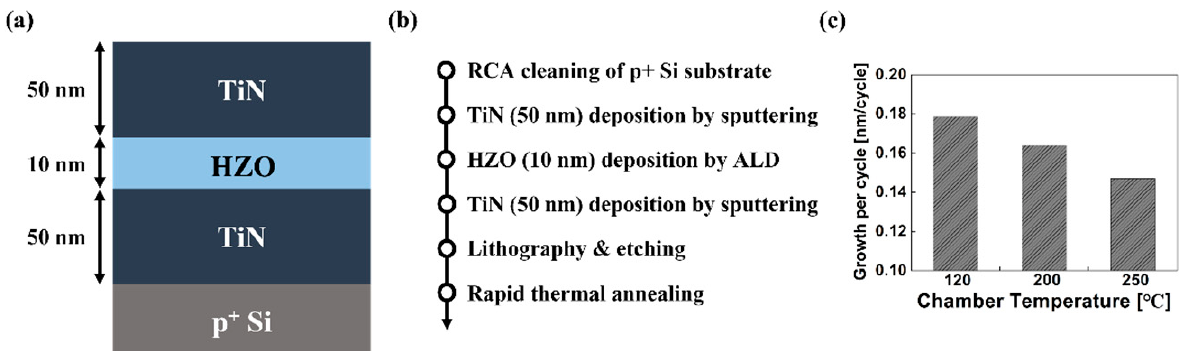
Figure 1. ( a ) Illustrated cross-sectional view of the fabricated TiN/HZO/TiN capacitor, and ( b ) its fabrication process flow. The HZO layer were deposited under three different temperatures in chamber, i.e., 120 °C, 200 °C, and 250 °C. ( c ) Growth per cycle of HZO film for three different cham- ber temperatures. Note that the growth per cycle is decreased with increasing the chamber temper- ature, which is due primarily to the decreasing contribution of surface exchange reaction [13].